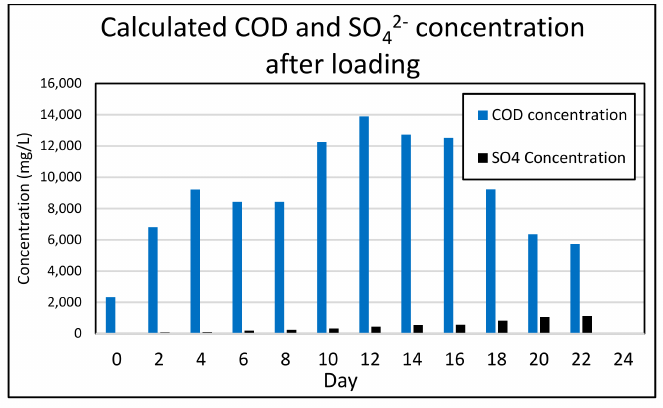
Figure 6. Calculated COD and SO 42 − concentrations following loading.